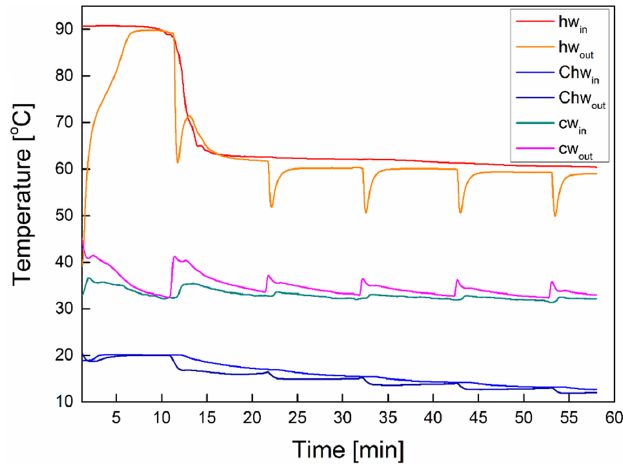
Figure 8. Variation of the chiller’s inlet and outlet temperatures.